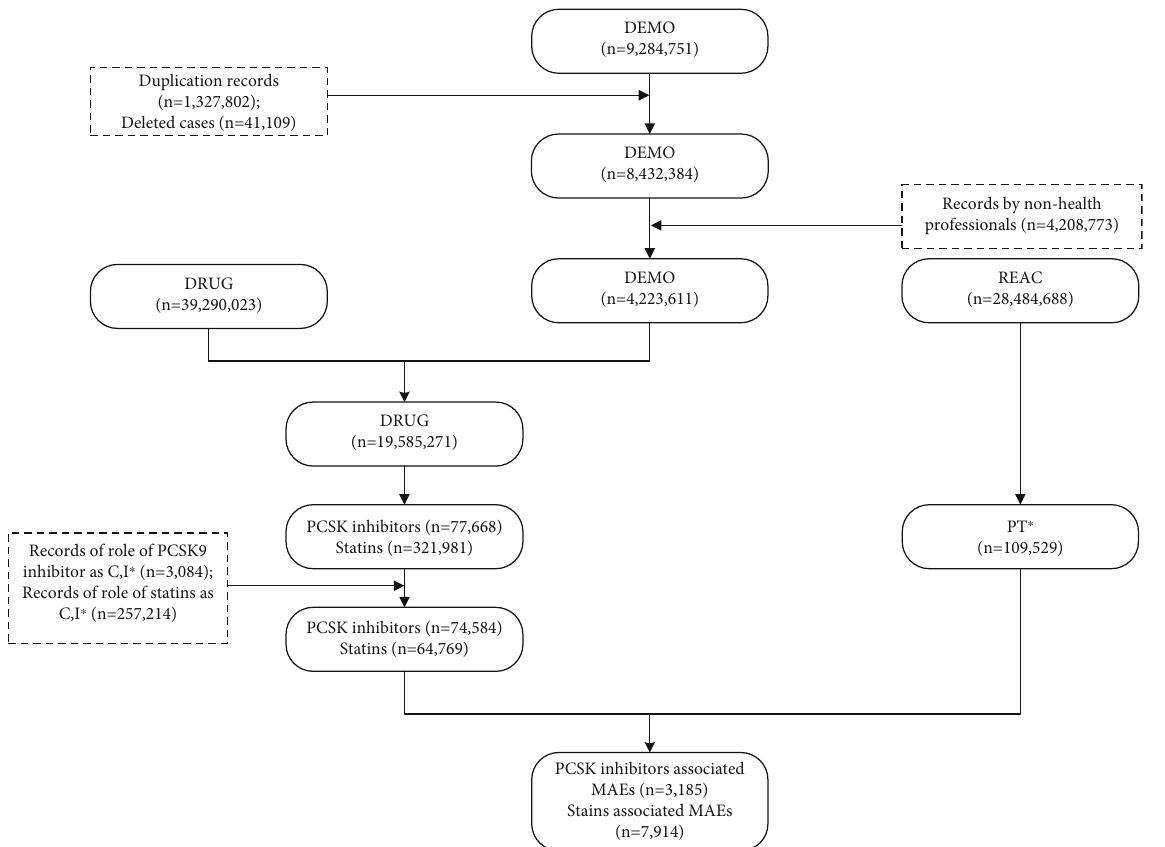
Figure 1: Flowchart of identifying cases with musculoskeletal adverse events reported by health professionals from FAERS